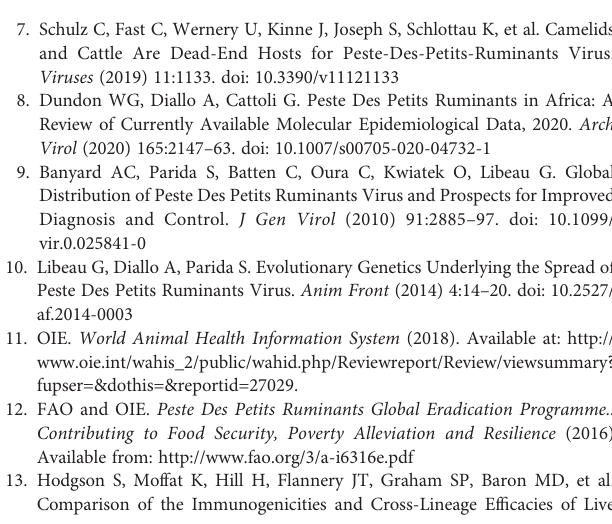
Supplementary Figure 1 | Principal component analysis (PCA) of the RNA sequencingandproteomicdata collectedfromPPRVinfectionsofPBMCs. (A) PCA of RNA sequencing data obtained in each condition at 72 hpi. (B) PCA of proteomic data obtained in each condition at 48 hpi (J2), 72 hpi (J3) and 96 hpi (J4). CTRL in proteomic data represent the Mock group. Supplementary Figure 2 | Common and speci fi c regulated genes between PPRV infections. (A) Gene ontology (GO) analysis of commonly upregulated genes between all infections. (B) GO analysis of speci fi cally upregulated and downregulatedgenes (C) inMA08infection.Sourcerepresentssigni fi cant(adjusted pvalue < 0.05) GO categories BP (biological processes), CC (Cellular Components), MF (Molecular Functions) and KEGG pathways obtained from g:Pro fi ler. The rich factor is the number of genes found in the analysis divided by the number of genes in the GO category. (D – F) represent the log2 fold change values of upregulated genes found in common between VN75/1 and IC89 (D) , MA08 and VN75/1 (E) and VN75/1 and IC89 infections. Supplementary Figure 3 | Representation of genes involved in the repression of viral replication during PPRV infections. Red circles, squares, triangles or diamonds represent genes that are upregulated during infection, while green ones represent genesthatare downregulated. Genesfoundseveraltimesin theanalysisare tagged with an asterisk. The broken lines represent the predicted relationships between genes and biofunction. Blue lines lead to inhibition, yellow lines represent results inconsistent with the state of the downstream molecule and grey lines represent non-predicted